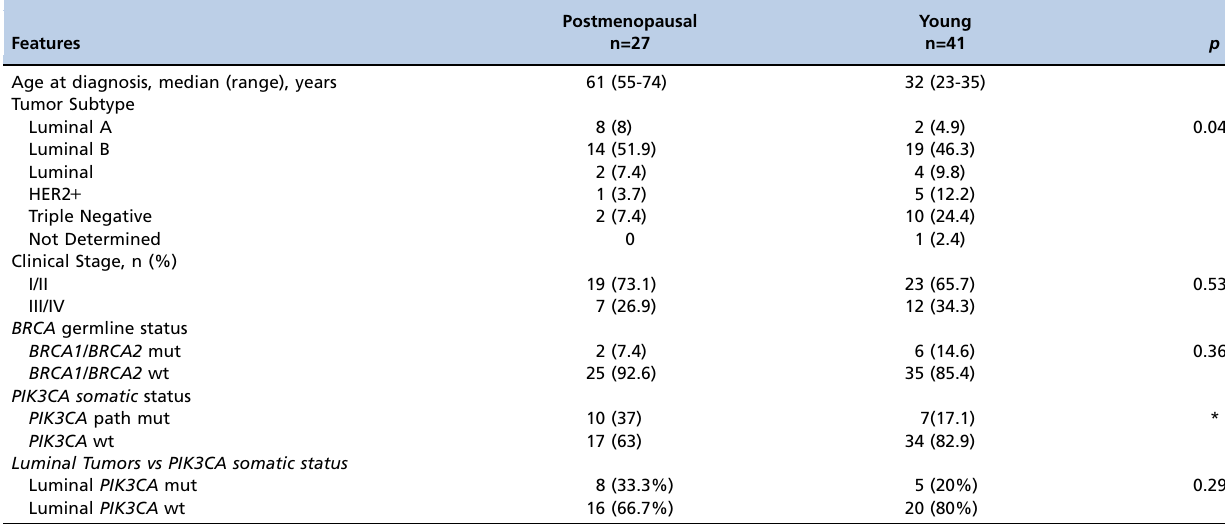
Table 4 - Clinical and pathological features of breast cancer patients according to their age.